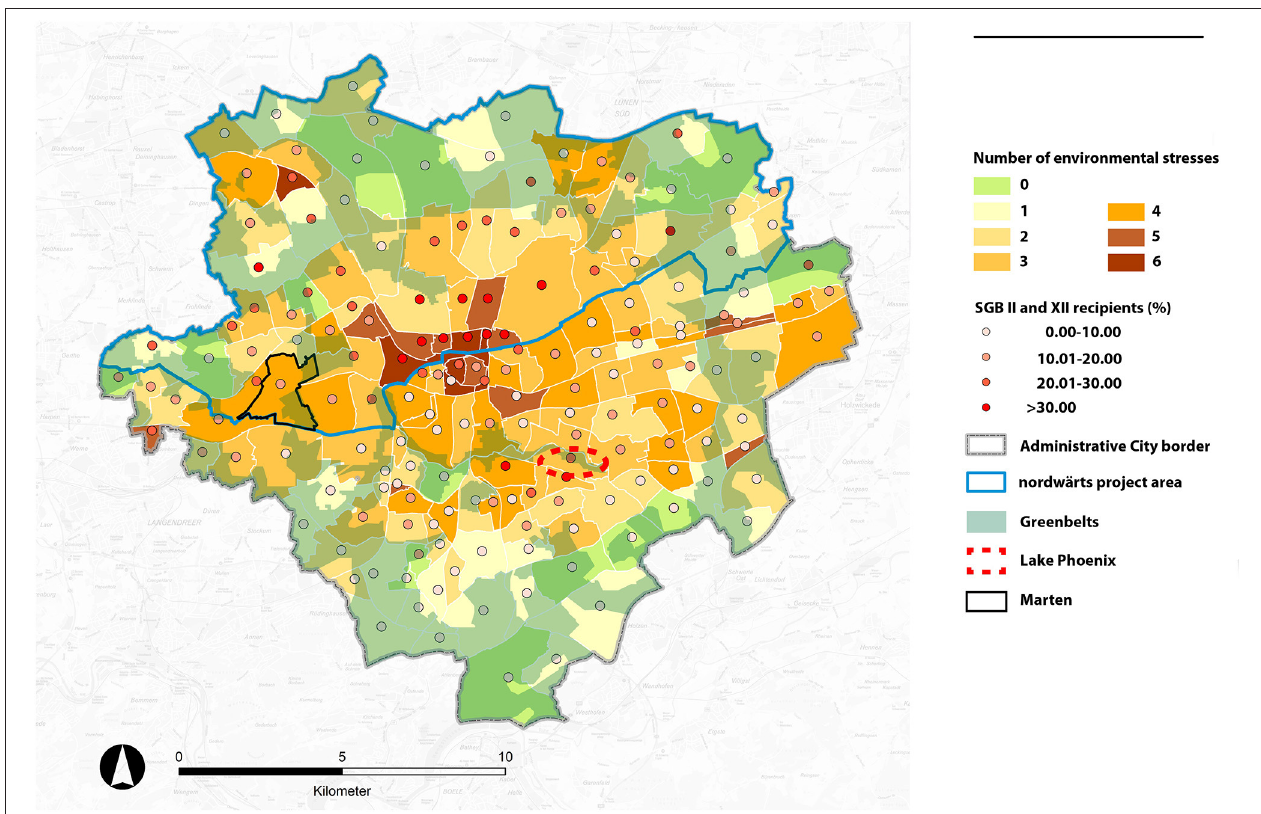
FIGURE 6 | Multiple-load map for Dortmund (modified from source: Bakunowitsch et al., 2019,